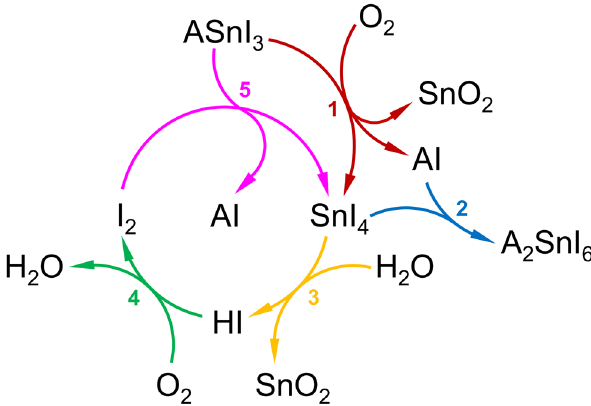
Fig. 1 Proposed cyclic degradation mechanism of a tin iodide perovskite under ambient air exposure. Unless stated otherwise, ‘ A ’ refers to the organic cations chosen for the preparation of the hybrid tin perovskite (20% PEA and 80% FA in the present work). Reaction 1: oxidation of perovskite by O 2 and SnI 4 formation; Reaction 2: solid-state formation of A 2 SnI 6 from SnI 4 and AI, where A ≡ FA. Reaction 3: hydrolysis of SnI 4 by H 2 O and HI formation; Reaction 4: oxidation of HI by O 2 and I 2 formation; Reaction 5: oxidation of perovskite by I 2 and SnI 4